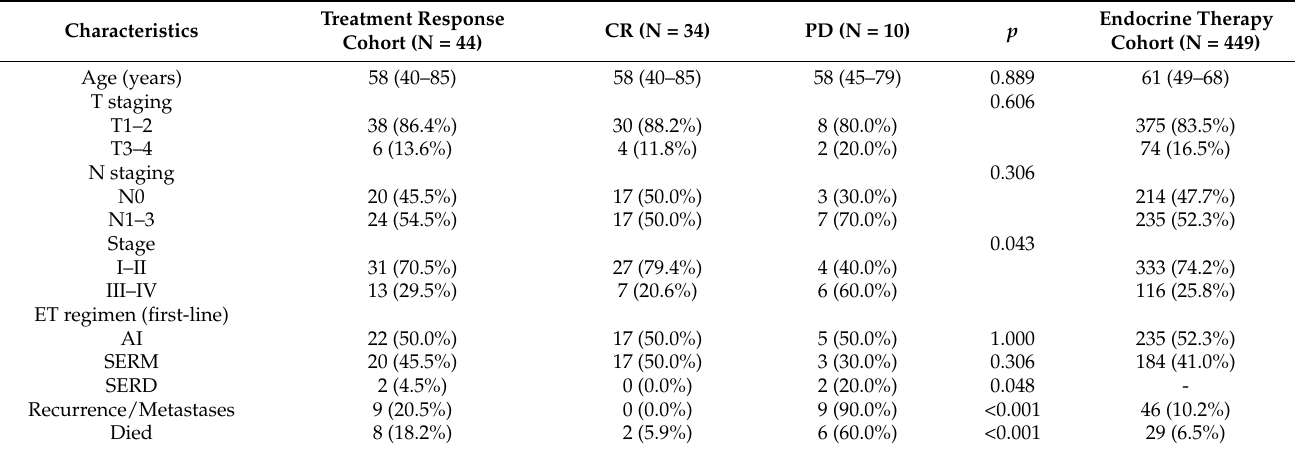
Table 2. Baseline distribution of treatment response and endocrine therapy cohort in RNA-seq dataset.